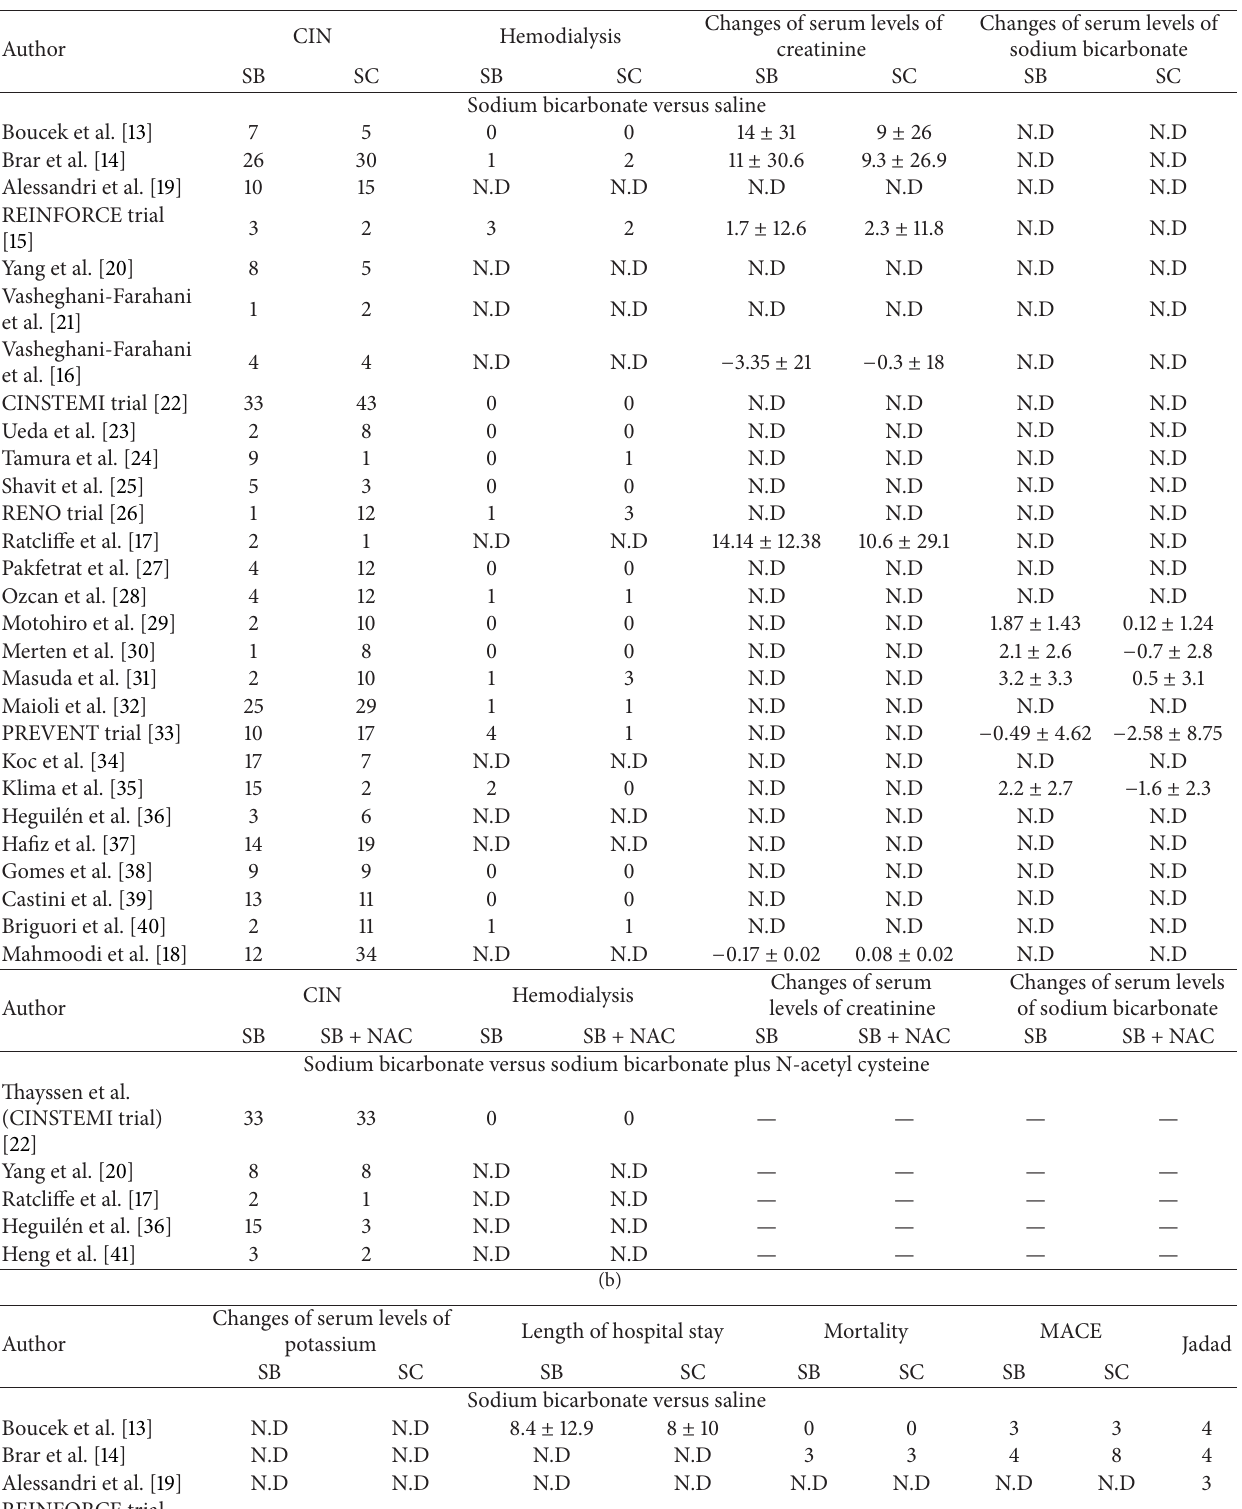
Table 2: Clinical outcomes of included